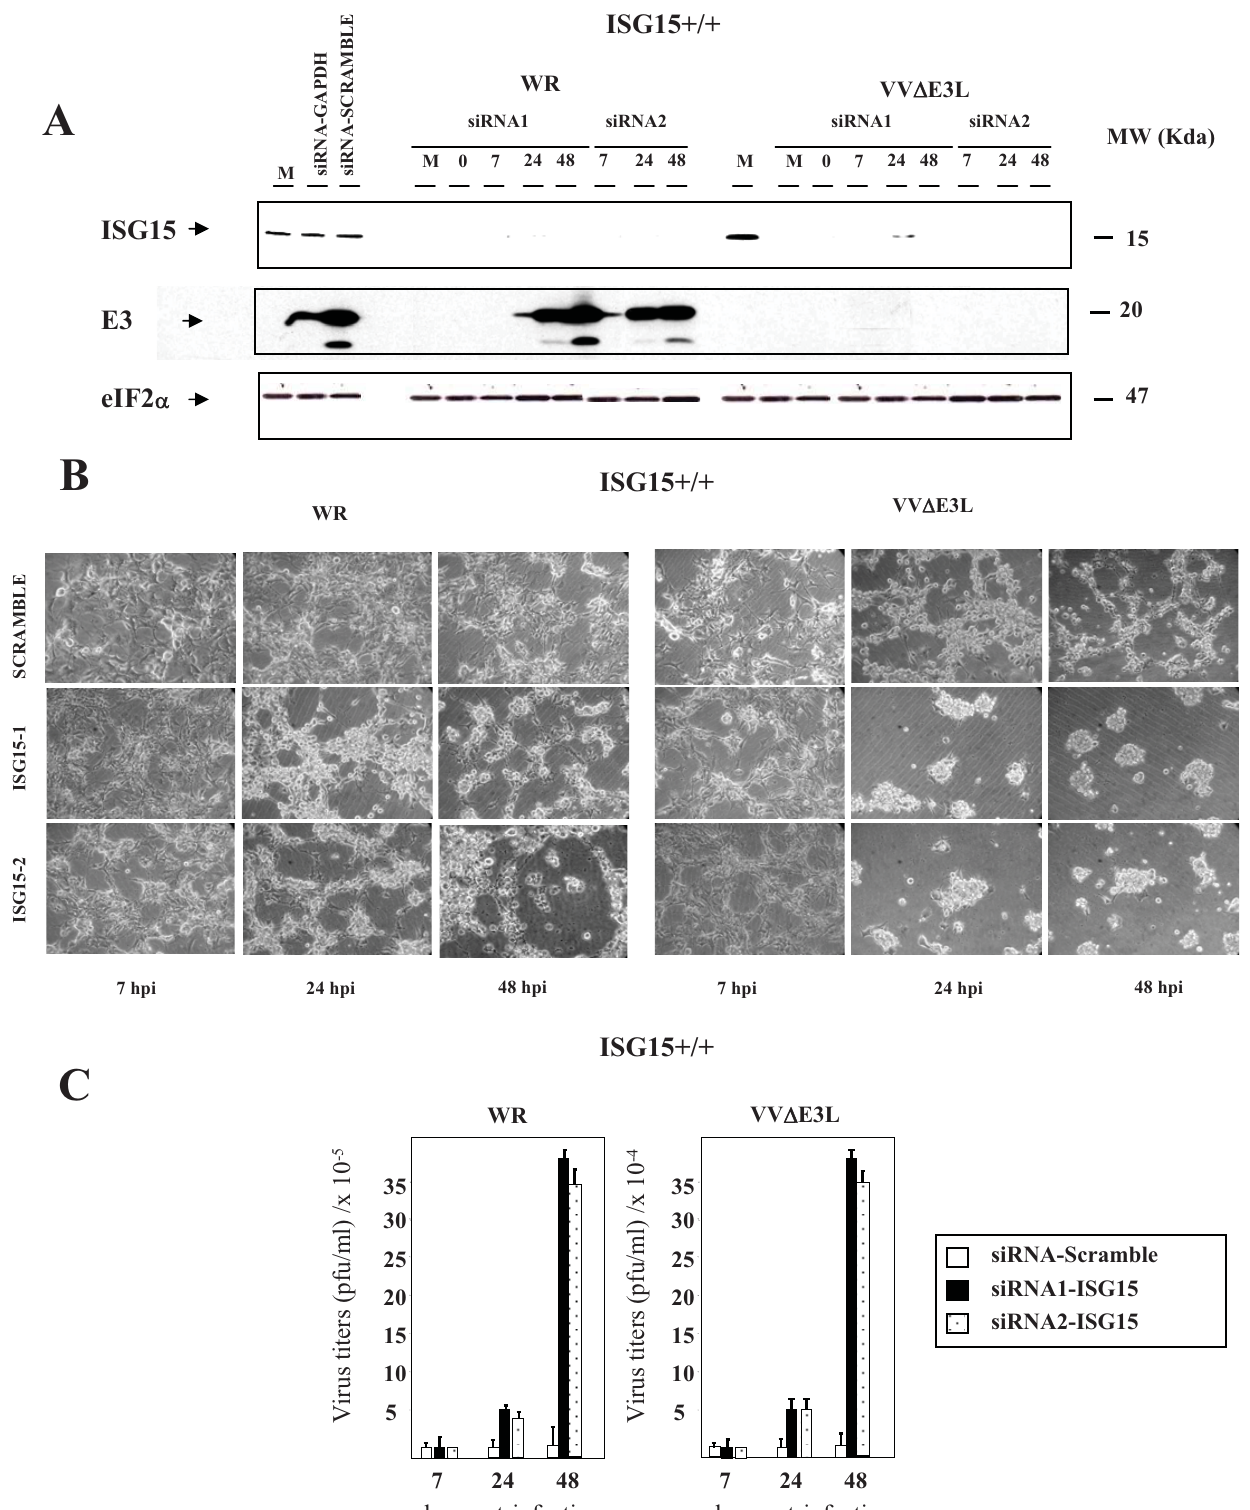
Figure 3. Anti VACV role of ISG15 protein expression using siRNA. MEFs were transfected with ISG15 synthetic siRNA (siRNA1 or siRNA2), scrambled siRNA (used as a negative control) and GAPDH siRNA (used as a positive control) and 24 hours after transfection, siRNA-treated and non- treated control cells were mock- or infected with different WR or VV D E3L viruses at 0.1 PFU/cell. A . Levels of ISG15 were measured by Western-blot using a specific murine anti-ISG15 antibody. Viral protein E3 levels were measured as a control of infection and levels of eIF2 a were used as a loading control. B . CPE was visualized by phase-contrast microscopy at the indicated times p.i. C . Virus growth of WR and VV D E3L were determined by plaque assay or by immunostaining at the indicated times